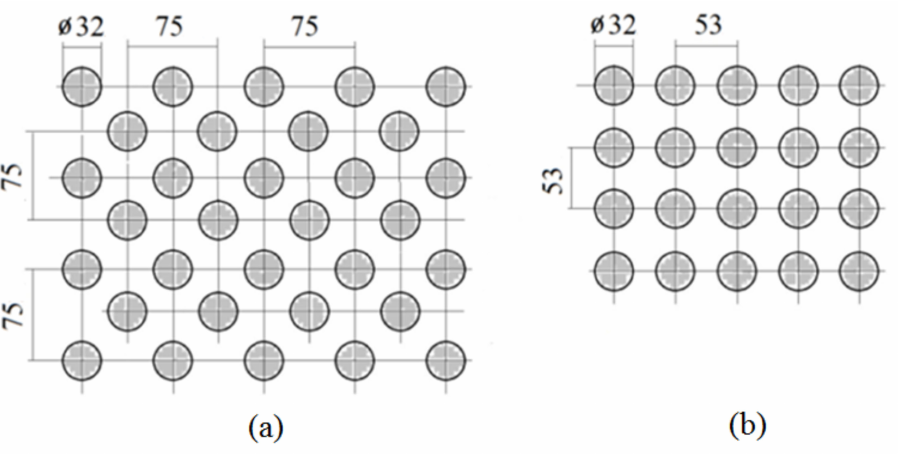
Figure 3. Configuration of the tubes in the package. ( a )—chess arrangement; ( b )—corridor arrange- ment. Dimensions in